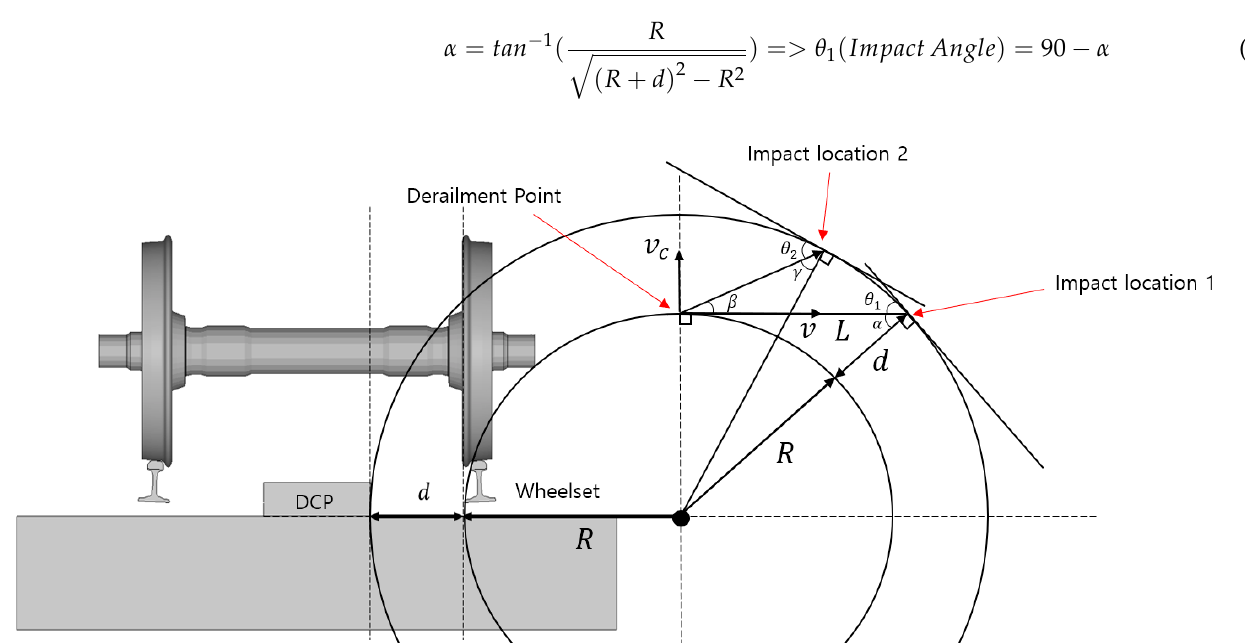
Figure 7. Impact angle of a curved track.